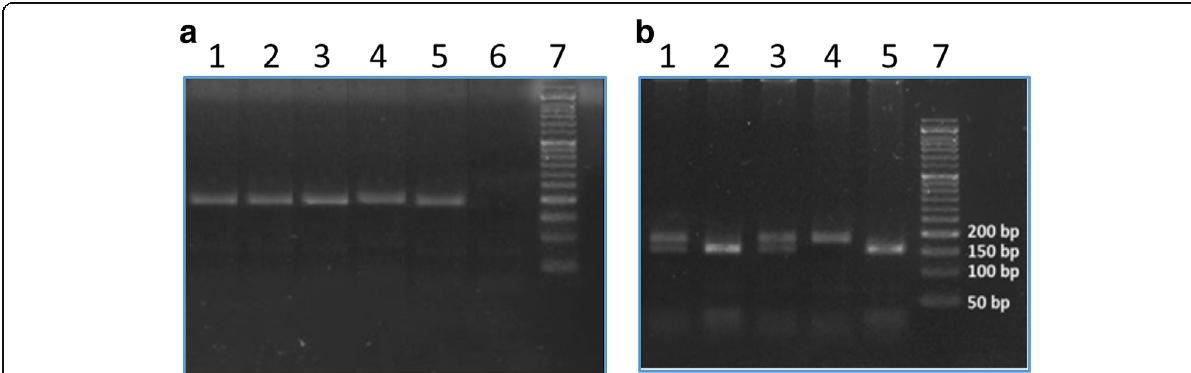
Fig. 1 Agarose gel electrophoresis (2%) of FTO gene variant ( a ) PCR products showing 187 bp amplicon (Lanes 1 – 5), lane 6: Negative control, lane 7: 50 bp ladder. ( b ) Digested PCR product representing different genotypes: Lanes 1, 3: AT genotype; Lanes 2, 5: AA genotype; Lane 4: TT genotype; Lane 7: 50 bp